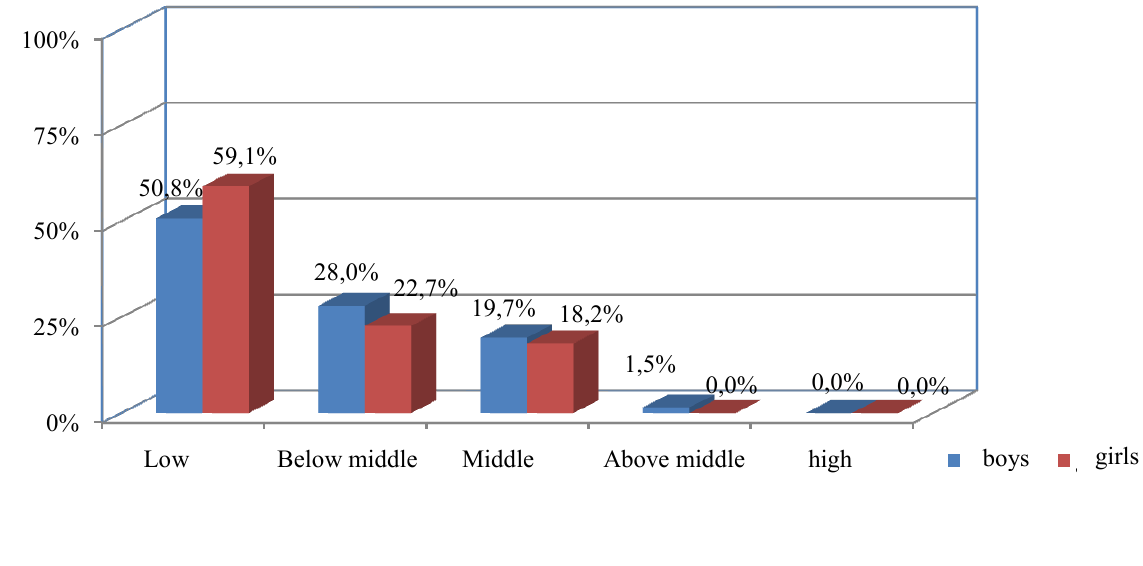
Fig.1. Distribution of first year technical specialties’ students by levels of somatic